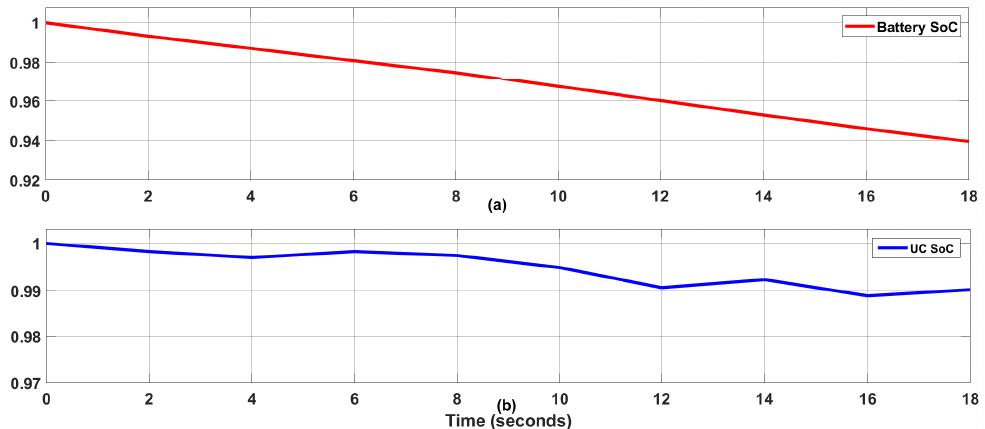
Figure 17. ( a ) Case:II SoC of Battery ( b ) Case:II SoC of